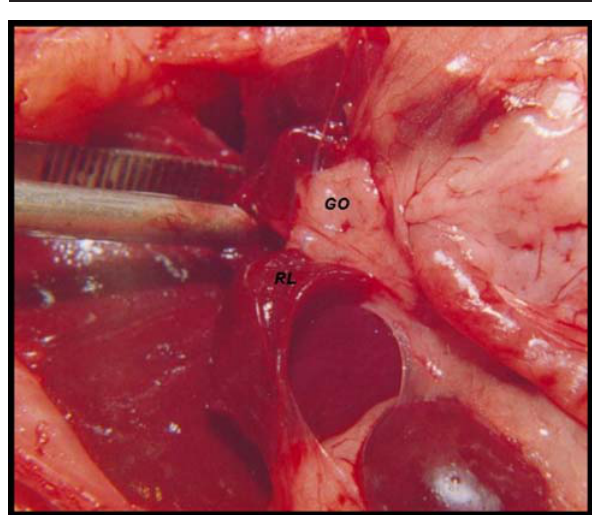
FIGURE 3 - Macroscopic aspects of the omentum-hepatic region, showing the presence of vascularization in the greater omentum ( GO ) transposed onto the right lobe ( RL ). Group with simultaneous HA and PVRB ligation at POD 90,